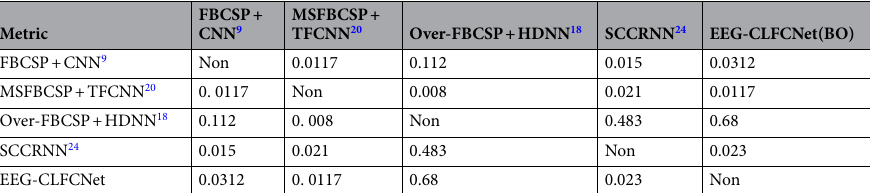
Table 8. Cross models Wilcoxon signed ranked test. Each row demonstrate level of significance for a model against different